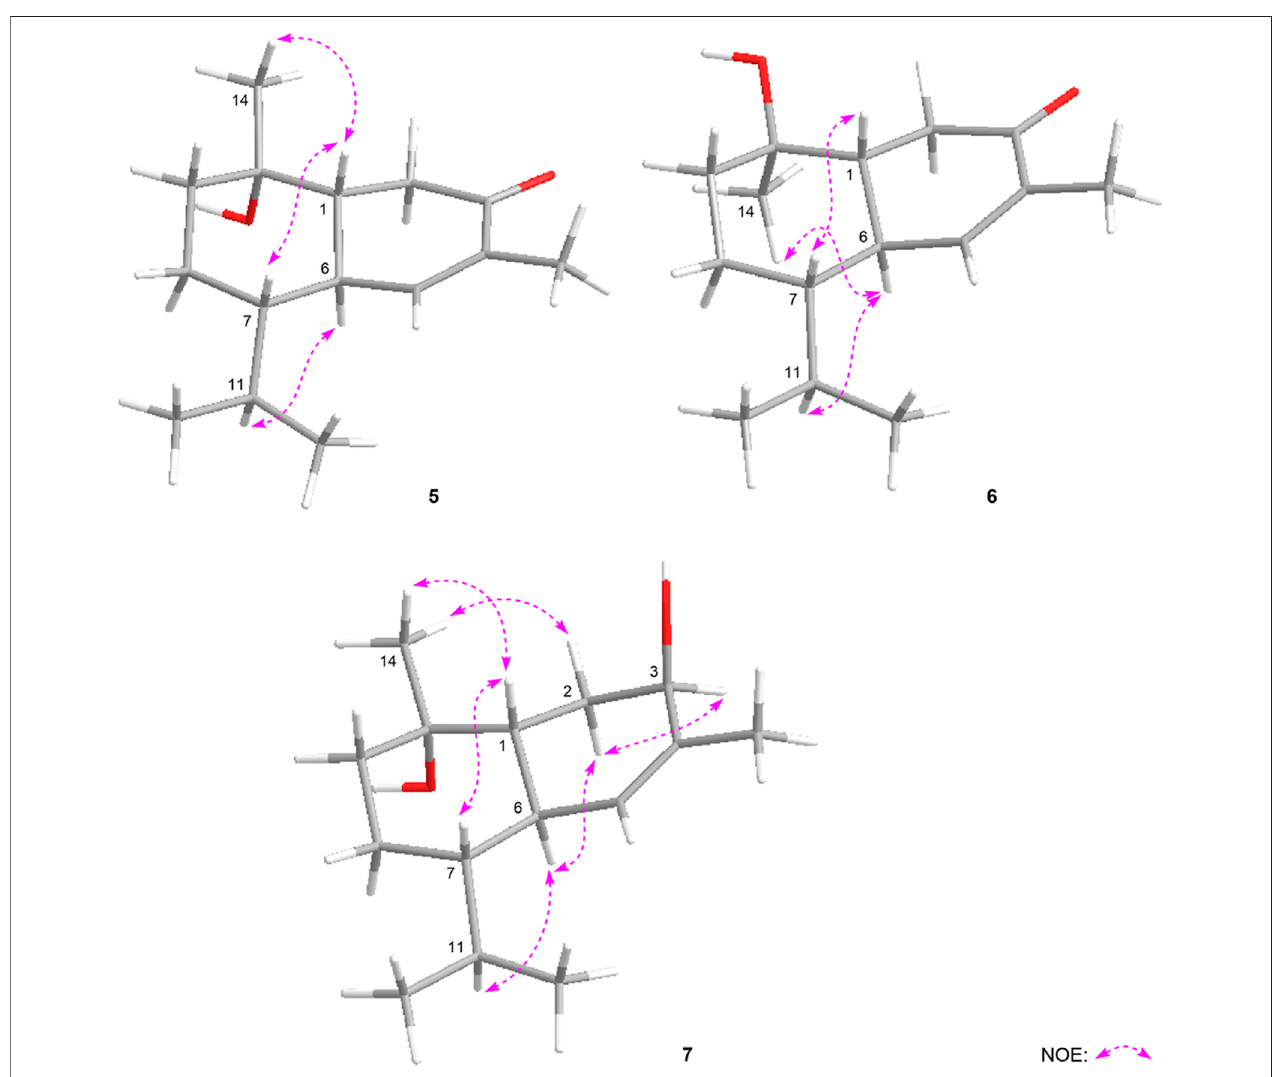
FIGURE 6 | The main NOE correlations of 5 – 7